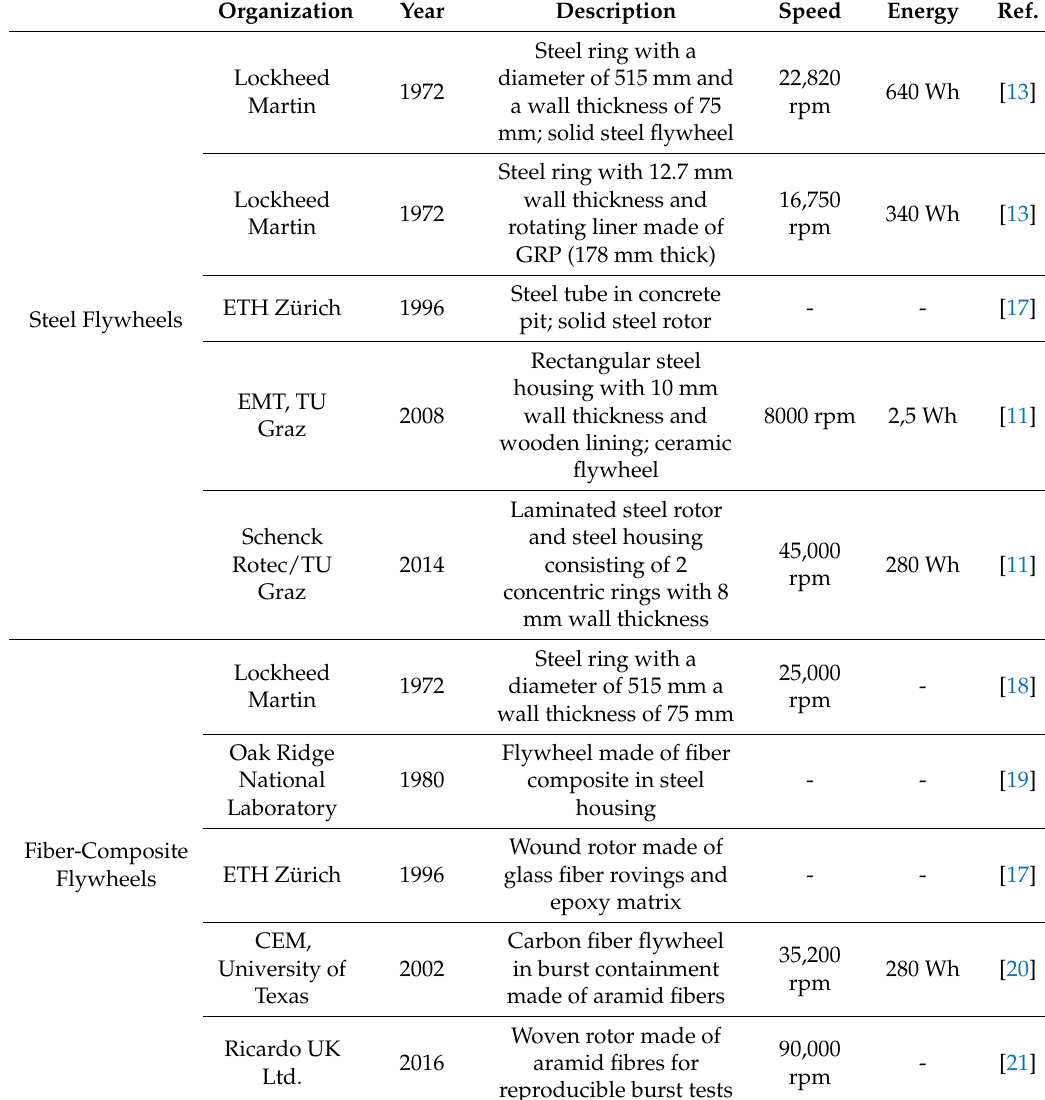
Table 1. Over-speed tests of steel and fiber-composite